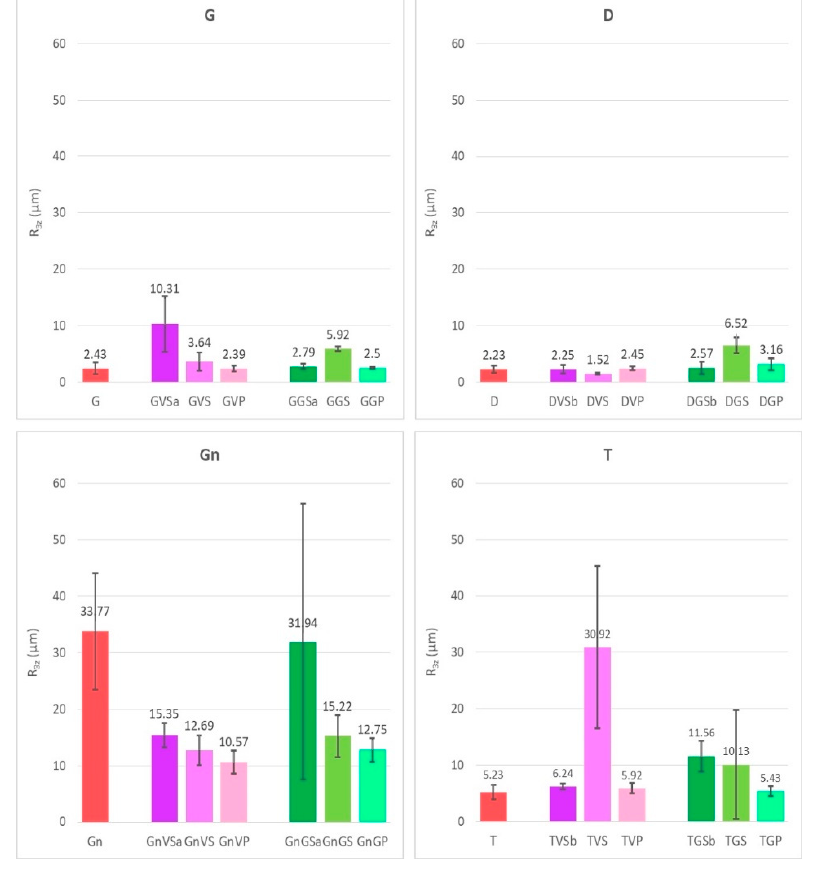
Figure 6. Roughness parameter R 3z of the uncoated stone and the surfaces coated with either the sacrificial or permanent anti-graffiti product after being cleaned with the respective products. n = 3. Standard deviation is also shown. Check Table 1 for sample labeling.